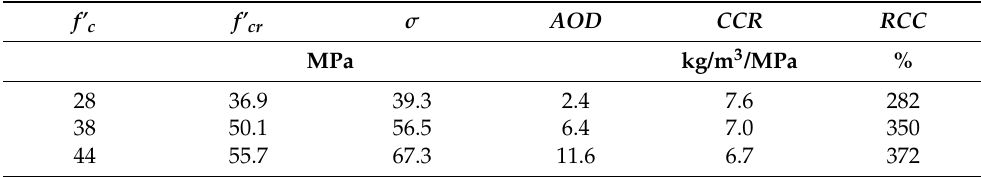
Table 4. Required cementitious content in concrete 1